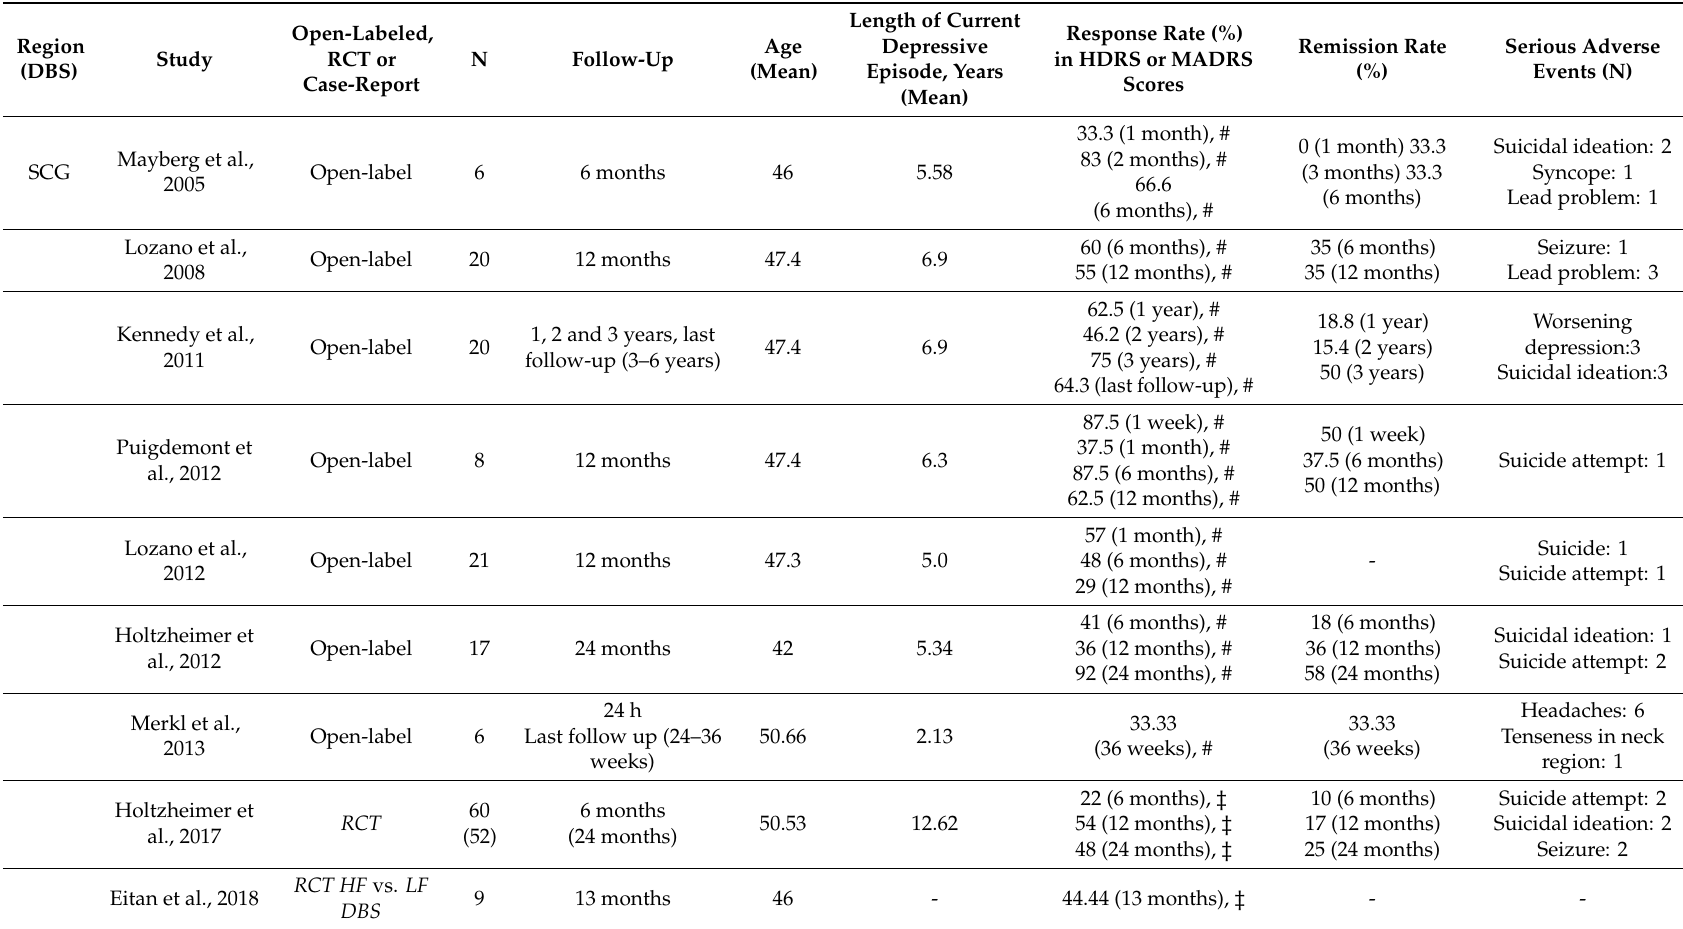
Table 1. DBS in treatment-resistant depression (TRD); published open-label and randomized clinical trials.